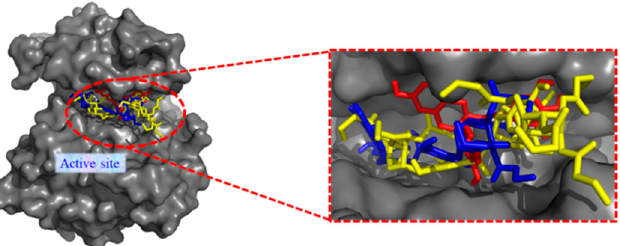
Figure 4. Proposed binding modes of the small molecules at the site of EGFR: binding modes of EGCG (in red), 11 (in blue), and 12 (in yellow) in the active site of EGFR (PDB code: 2ITY) by overview and zoom-in of ATP-binding pocket.